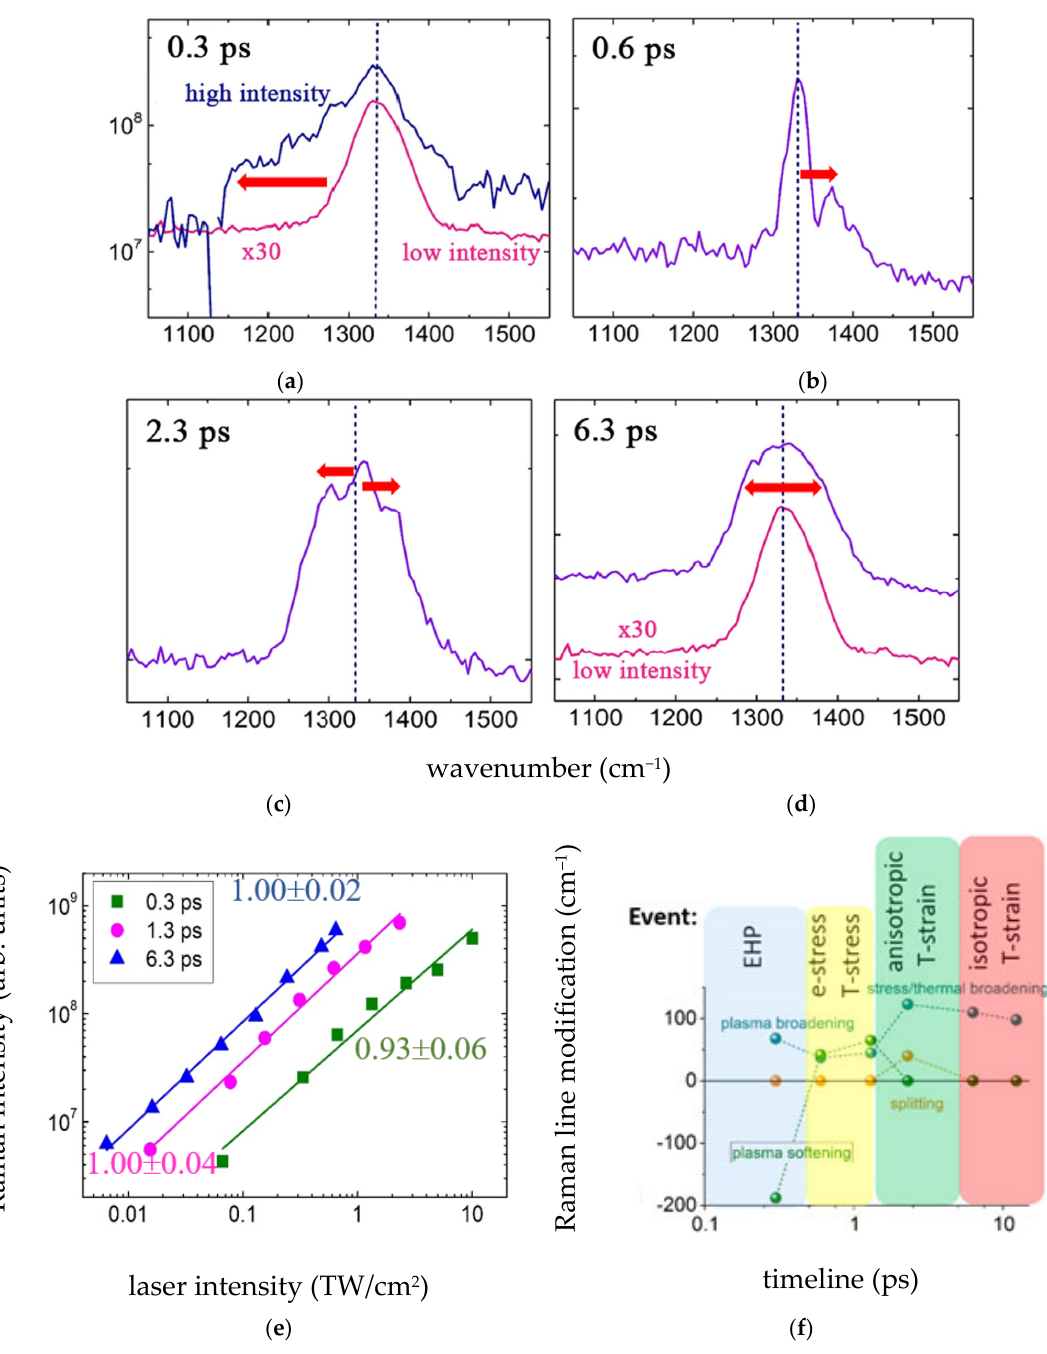
Figure 8. ( a – d ) Stokes’ first ‐ order Raman spectra of the center ‐ zone optical phonon in natural dia ‐ mond #1 at variable 515 nm laser pulsewidths of 0.3, 0.6, 2.3, and 6.3 ps, respectively. The red hori ‐ zontal arrows show broadening, shifting, and splitting effects. The low ‐ intensity reference line cor ‐ responds to the 0.3 ps photoexcitation at 0.24 TW/cm 2 ; ( e ) linear log–log dependences of Raman intensity on laser intensity at the different pulsewidths with their power slopes; ( f ) timeline of lattice relaxation processes emerging in the Raman spectra ( a – d ) according to their shifts, broadening and splitting. Adapted from [112].